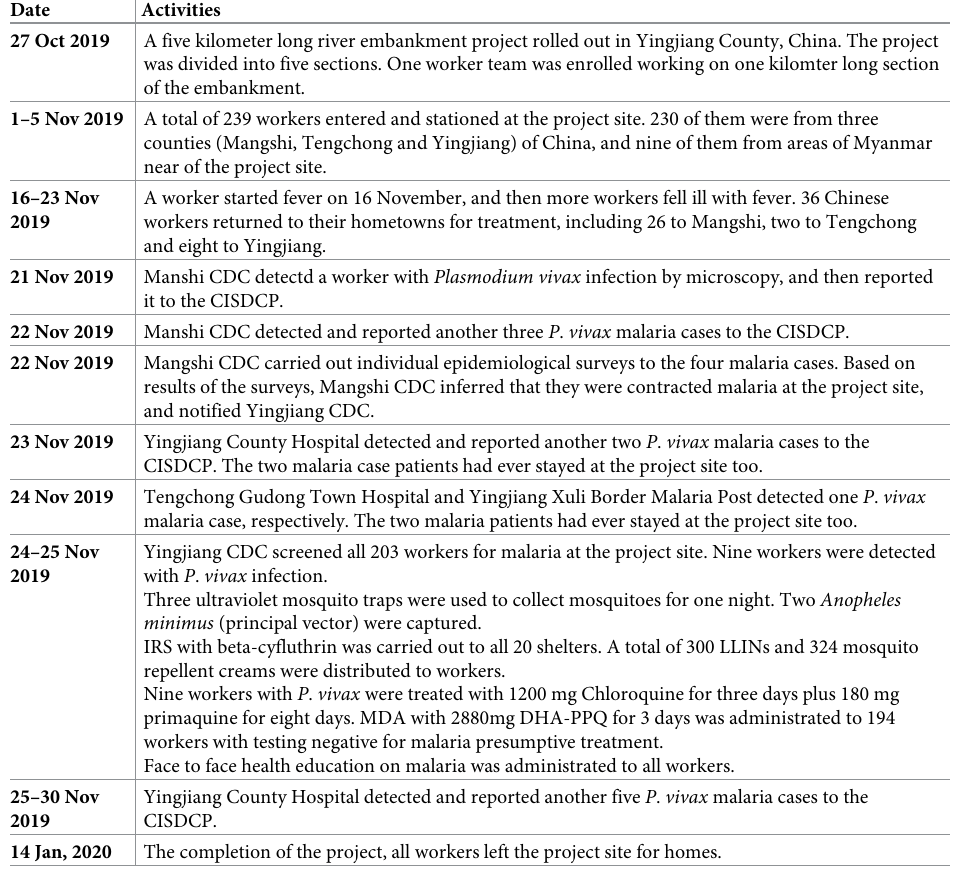
Table 1. The river embankment construction; and malaria outbreak, detection and public health response from 27 October, 2019 to 14 January,